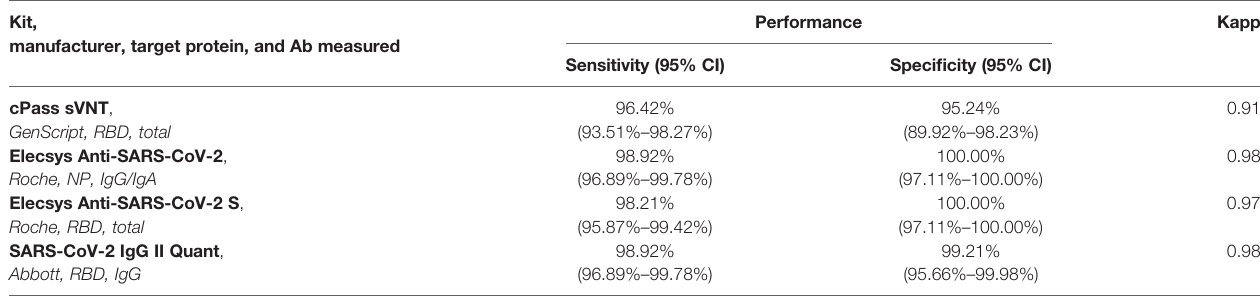
TABLE 2 | Analytical performance of each kit in discriminating SARS-CoV-2 infection. Kit, manufacturer, target protein, and Ab